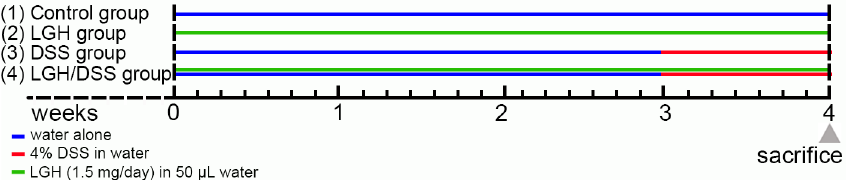
Figure 1. Timing of DSS induction of colitis and LGH administration. Mice were randomly divided into the groups as follows: (1) Control group ( n = 3; blue line) with normal chow diet and drinking water; (2) LGH group ( n = 3; green line) with LGH gavage feeding; (3) DSS group ( n = 3) with 4% DSS (indicated by red line) in drinking water; (4) LGH/DSS group ( n = 3) with LGH gavage feeding plus 4% DSS in drinking water. Gray triangle, end of day for sacrifice. DSS, dextran sodium sulfate; LGH, longish glucomannan hydrolysates.